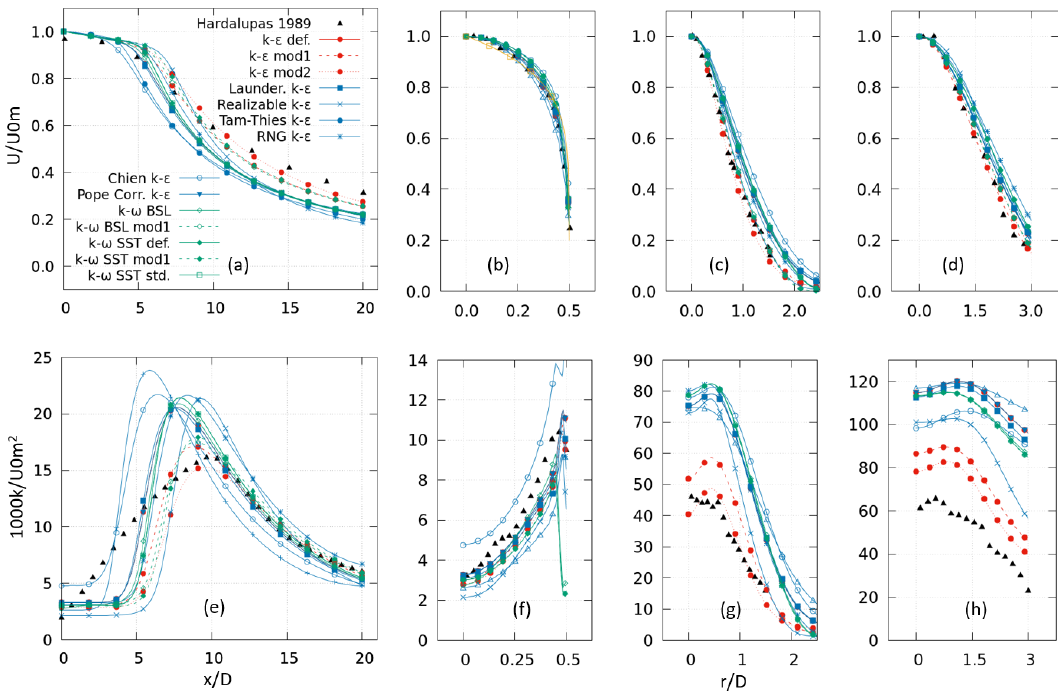
Figure 3. Test case Hardalupas et al. [1] normalized velocity profiles at ( a ) axial and ( b ) 0.1D, ( c ) 10D, and ( d ) 20D normal planes, and normalized turbulent kinetic energies at ( e ) axial, and ( f ) 0.1D, ( g ) 10D, and ( h ) 20D normal